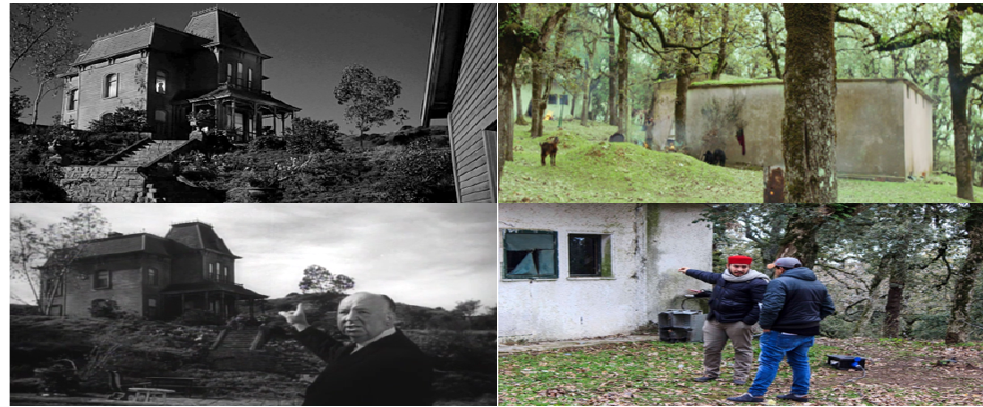
Figure 16: A motel lost in a forest in Dachra like in Psycho